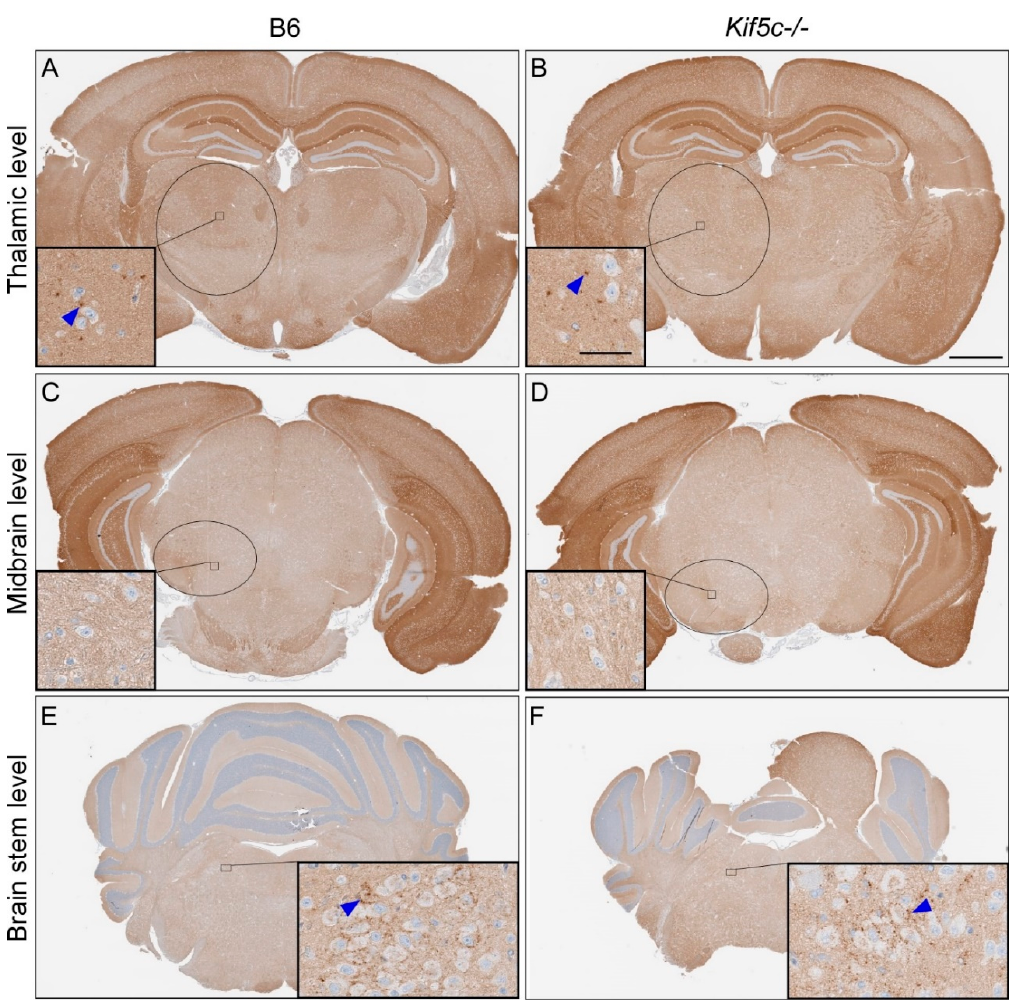
Figure 5. PrPSc staining of mouse brains 40 days post ME7 scrapie inoculation. IHC using anti-PrP antibody D13 was performed on coronal sections from three areas. A representative B6 mouse is shown on the left side, and a Kif5c − / − mouse on the right. ( A , B ) Coronal sections through the thalamus. The black oval depicts the approximate borders of the thalamus and the high magnification insets show very subtle, focal PrPSc staining (blue arrowheads). ( C , D ) Midbrain sections including the substantia nigra (black ovals). Insets show higher magnification, no PrPSc was observed in the mice shown. ( E , F ) Rostral pons sections and higher magnification insets showing perineuronal PrPSc. The scale bar in B is 1 mm and applies to all the large panels. The scale bar in the inset within panel B is 50 µ m and applies to all the